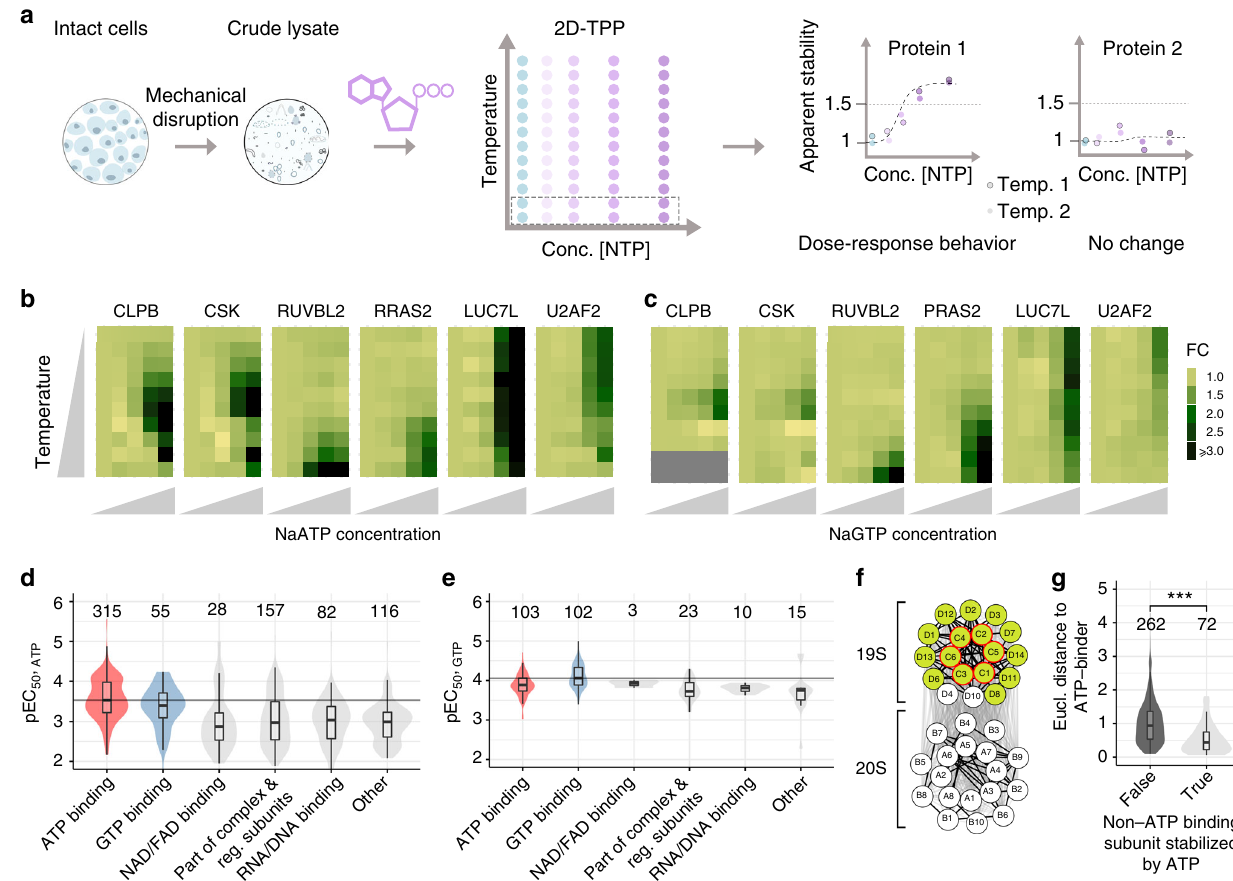
Fig. 1 Effect of ATP and GTP on proteome thermal stability. a Experimental setup of 2D thermal proteome pro fi ling (2D-TPP) using crude lysate system. Dotted rectangular box corresponds to one TMT10 experiment. Blue circles indicate untreated lysate and circle in increasing intensities of purple represent increasing concentration of ligand of interest added to the lysate. Data from three independent experiments have been analyzed. b Heat maps showing relative fold changes (FC) of protein abundance upon treatment with ATP (0.005, 0.05, 0.5, and 2 mM) compared to untreated crude lysate ( fi rst column on each plot) with increasing temperature ( y -axis: 42, 44.1, 46.2, 48.1, 50.4, 51.9, 54.0, 56.1, 58.2, and 60.1 °C). c Heat maps showing relative FC of protein abundances upon treatment with GTP (0.001, 0.01, 0.1, and 0.5 mM) compared to untreated crude lysate ( fi rst column on each plot) with increasing temperature ( y -axis: 42, 44.1, 46.2, 48.1, 50.4, 51.9, 54.0, 56.1, 58.2, 60.1, 62.4, and 63.9 °C). d , e Distribution of − log10 half-maximal effective concentration (pEC 50 ) values of different classes of proteins as annotated in UniProt stabilized by ATP ( d ), and GTP ( e ). Black line represents the median pEC 50 of annotated ATP- and GTP-binding proteins upon addition of ATP and GTP, respectively. Numbers above violin plots represent number of proteins. f Network diagram showing effect of ATP on proteasome stability. Nodes with green ( fi lled) circles indicate ATP-stabilized subunits, and a red outline for nodes show known ATP-binding proteins of the complex. Edge thickness represents the Euclidean distance between the melting pro fi les of the different subunits. Thick lines are indicative of Euclidean distance less than 0.02. g Comparison of Euclidean distances between melting pro fi les of stabilized ATP- binding complex subunits and non-stabilized non-ATP-binding subunits, (left), and between stabilized ATP-binding complex subunits and stabilized non- ATP-binding subunits (right) within different complexes. Signi fi cance levels obtained from a Wilcoxon signed-rank test were encoded as *** p < 0.001. Numbers above violin plots represent numbers of non-ATP-binding subunits in protein complexes with at least one ATP-binding subunit. Violin plots represent relative densities. Center line in all box plots is the median, the bounds of the boxes are the 75 and 25% percentiles i.e., the interquartile range (IQR) and the whiskers correspond to the highest or lowest respective value or if the lowest or highest value is an outlier (greater than 1.5 * IQR from the bounds of the boxes) it is exactly 1.5 * IQR. Source data are provided as a Source Data fi le for panels B –